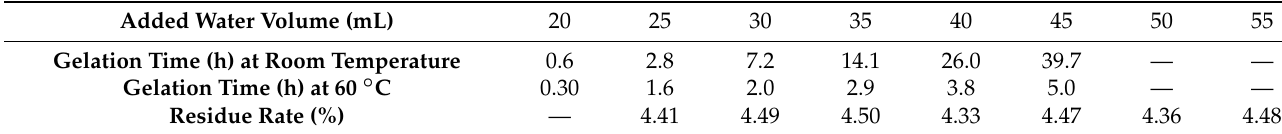
Table 1. Effect of adding different volumes of water to ACG on gel process.